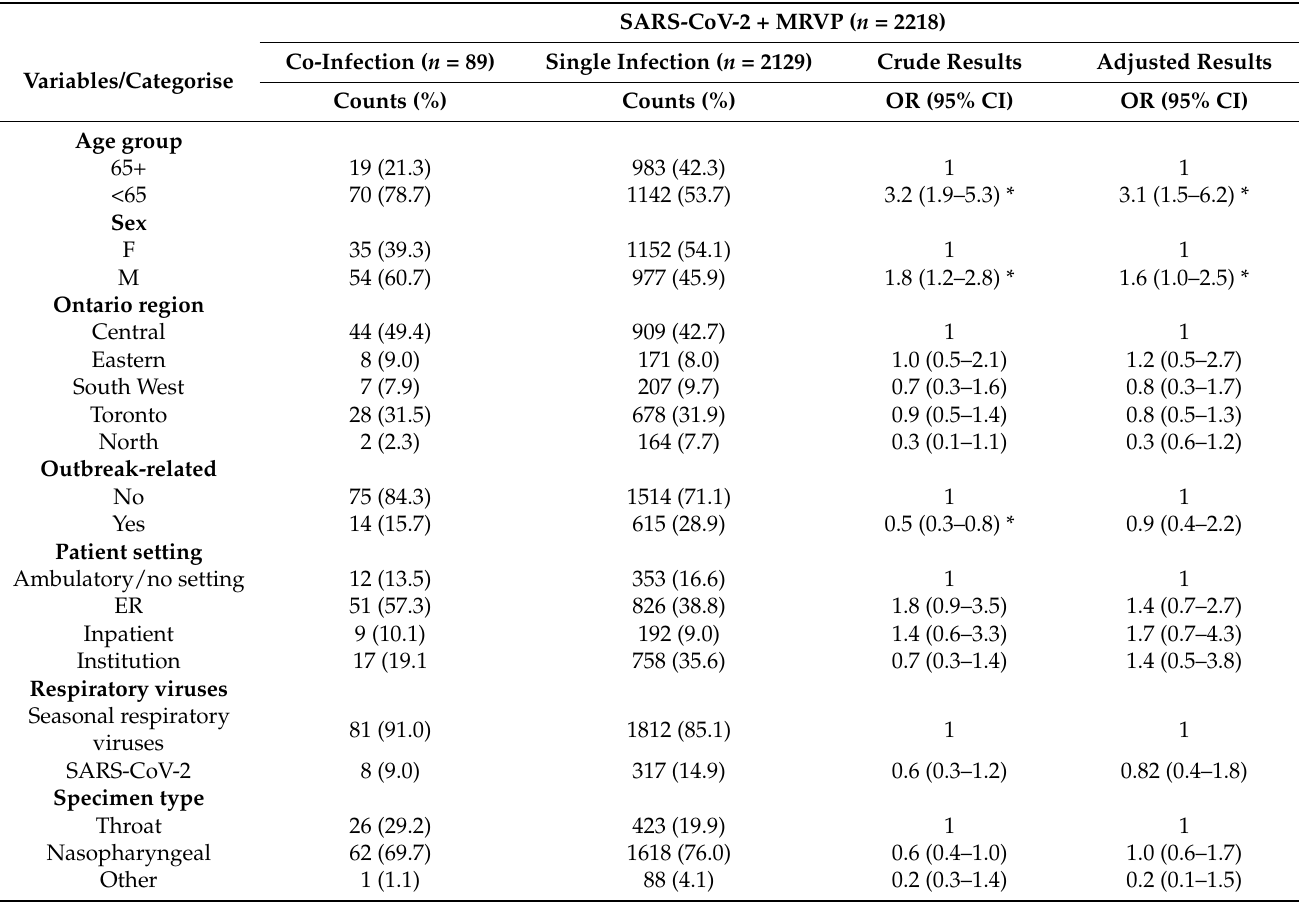
Table 5. Crude and adjusted logistic regression comparing characteristics of individuals with respiratory virus co-infection versus single infection among those tested by (i) SARS-CoV-2 +